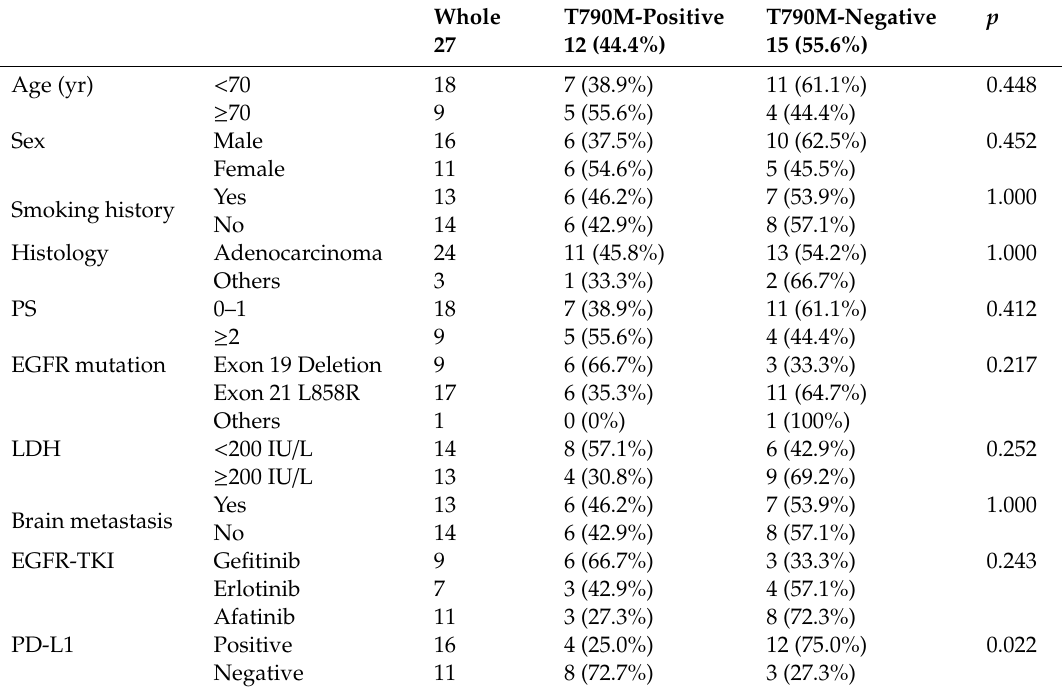
Table 4. Associations of the patient characteristics with the status of acquisition of the T790M mutation of EGFR.